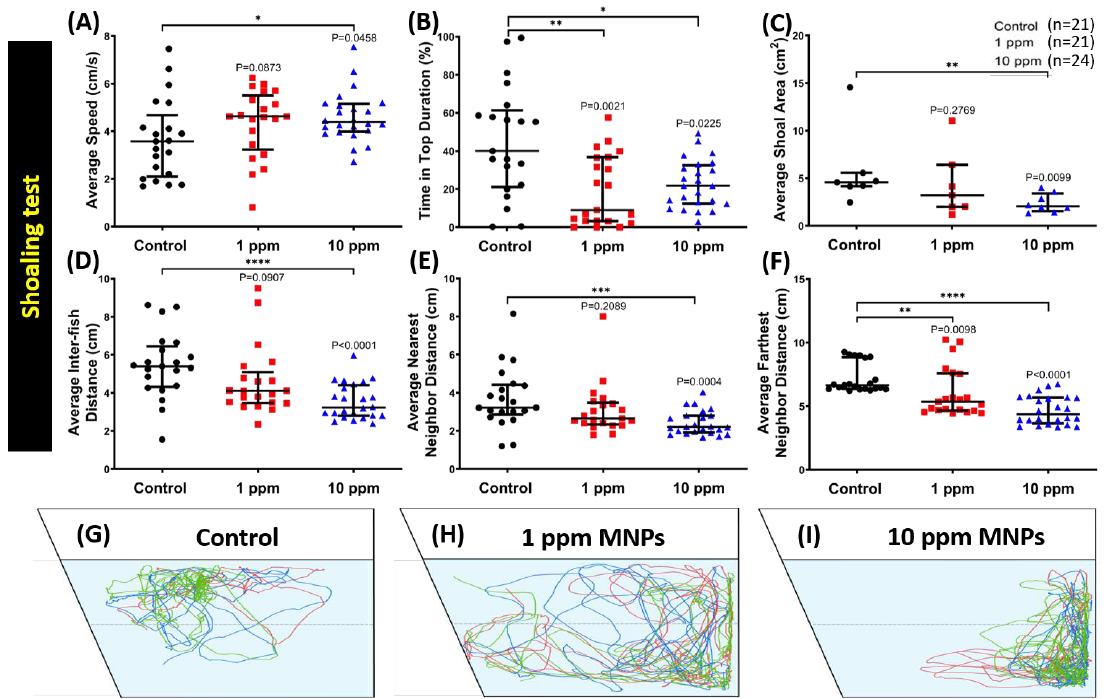
Figure 5. Shoaling behavior endpoint comparisons between the control group, 1 ppm, and 10 ppm Fe 3 O 4 MNPs-exposed zebrafish groups after two weeks of exposure. ( A ) Average speed, ( B ) time in the top duration, ( C ) average shoal area, ( D ) average inter-fish distance, ( E ) average nearest neighbor distance, and ( F ) average furthest neighbor distance were analyzed. ( G – I ) The locomotion trajectories for the control, 1 ppm and 10 ppm MNPs exposed fish in the shoaling test. Groups of three fish were tested for shoaling behavior. The data are expressed as the median with interquartile range and were analyzed by the Kruskal-Wallis test, which continued with Dunn’s multiple comparisons test as a follow-up test ( n = 21 for the control group and 1 ppm MNPs-exposed group, n = 24 for 10 ppm MNPs, * P < 0.05, ** P < 0.01, *** P < 0.001, and **** P < 0.0001).